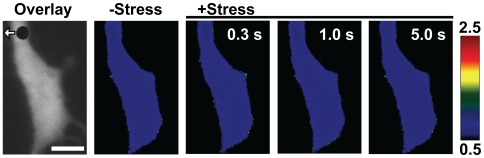
Rac activation by stress is specific.The cell was pretreated with a specific Rac inhibitor, NSC23766 (25 µM for 1 hr) before stress application. The rest of the protocol was the same as in Fig. 2 (A). There were no changes in FRET ratios in response to stress, suggesting that the drug prevented stress-induced Rac activation. Two other cells showed similar behavior. Left panel shows the YPet fluorescent image of the cell with the magnetic bead overlaid on top. White arrow represents bead movement direction. Scale bar = 10 µm.